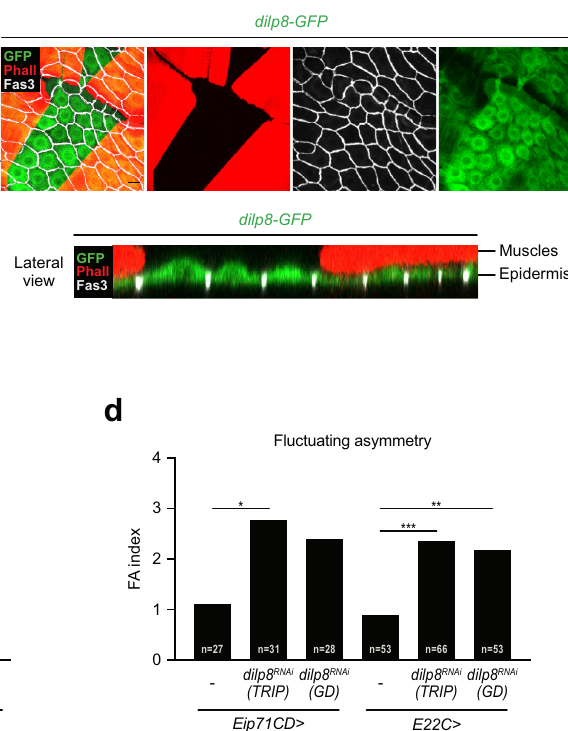
repeated independently more than 3 times with similar results. Brightness and contrast adjustments were performed without altering signal localization. c Measurement of dilp8 mRNA levels by qRT-PCR on whole animals at the WPP stage upon RNAi-mediated downregulation of dilp8 in the epidermis. Values are expressed as fold changes relative to controls without RNAi. Error bars represent SEM. *** p <0.0001, one-way ANOVA. n =3 biologically independent samples were analyzed for all genotypes. d FA indexes of adult wings upon RNAi-mediated downregulation of dilp8 in the epidermis. n values indicate the number of inde- pendent wing pairs analyzed; *** p =0.0004, ** p =0.0017 and * p =0.0193, for Eip71CD > dilp8 RNAi GD , p =0.0522; two-tailed F -tests. Experiments in c and d were done at 29°C. WPP white prepupa. Source data are provided as a Source Data fi